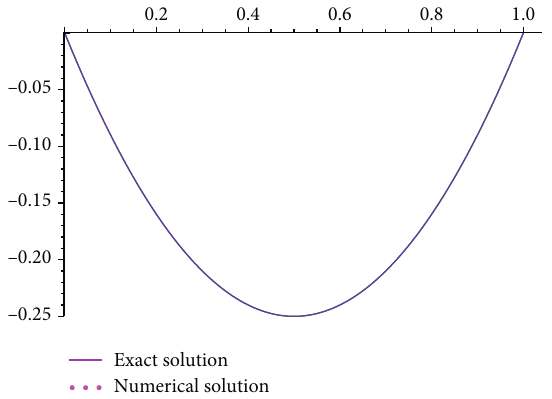
Figure 5: Absolute errors of u 1 obtained by the present method for Example 1.